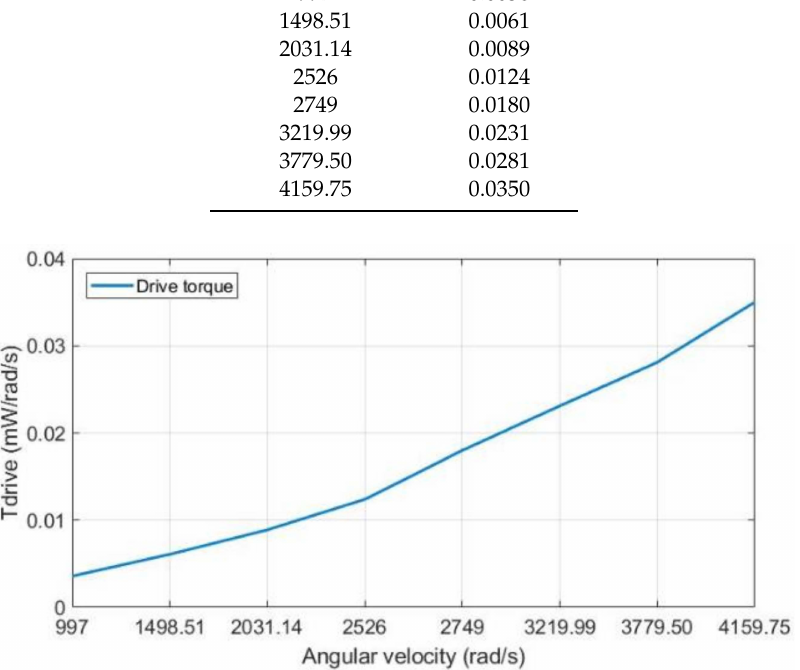
Figure 7. Torque vs. angular velocity.